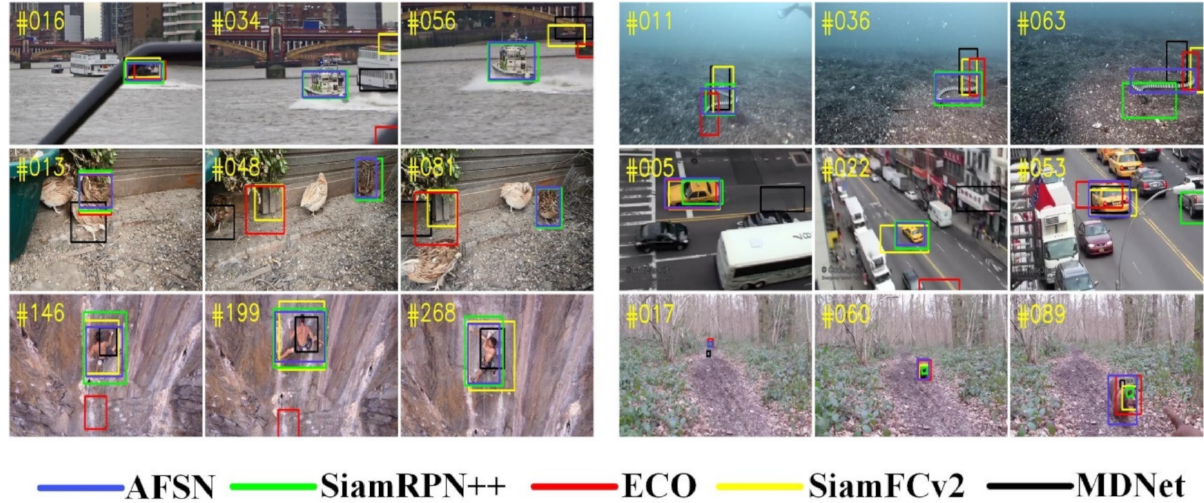
Figure 4. Qualitative result comparison of the proposed method with other trackers. AFSN: Anchor-Free Siamese Network; SiamRPN++: Evolution of Siamese Visual Tracking with Very Deep Networks; ECO: Efficient Convolution Operators; SiamFCv2: Fully-Convolutional Siamese Networks version 2; MDNet: Multi-Domain convolutional neural